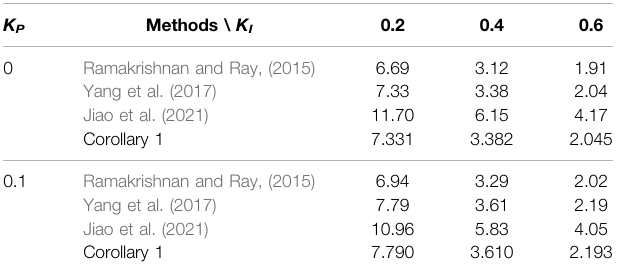
TABLE 3 | MAUB s h for μ (cid:2) 0 under one-area LFC